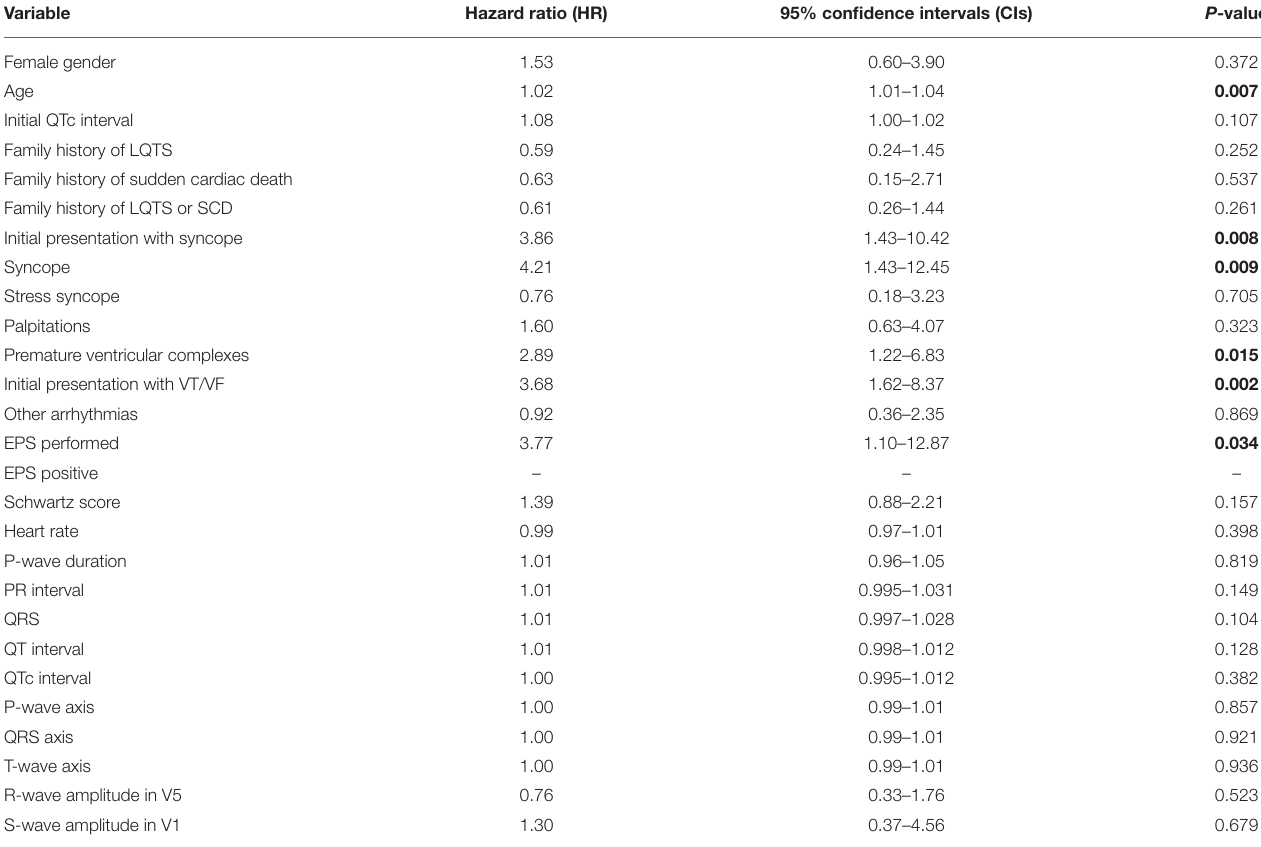
TABLE 2A | Univariate Cox regression analysis for shorter time to VT/VF post-diagnosis.